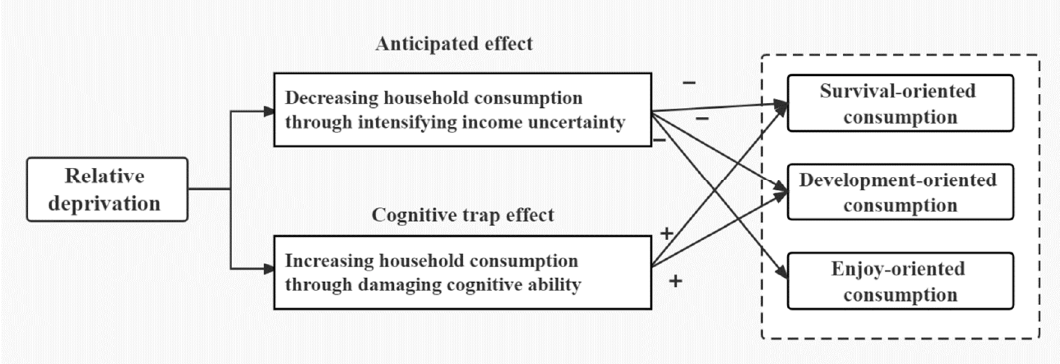
Figure 3. The influencing mechanism of relative deprivation on household consumption.